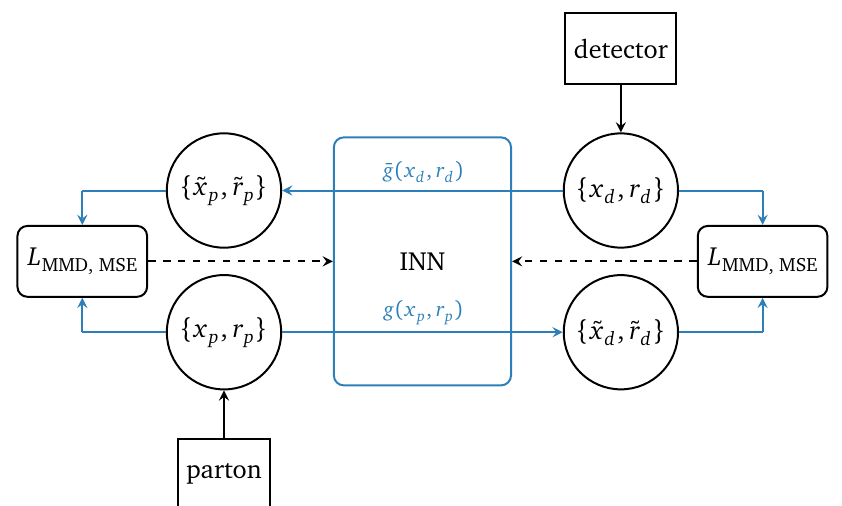
} denote detector-level and parton-level events, d , p